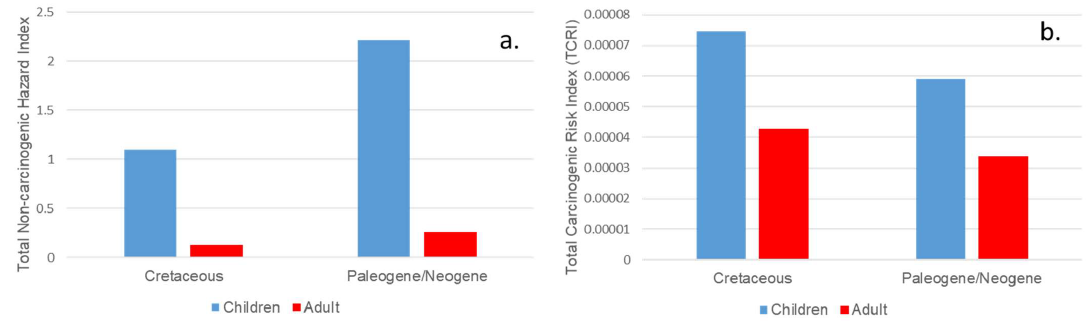
Figure 6. Plot of average total non-carcinogenic risk (a) and carcinogenic risk (b) for children and adults for trace elements in Cretaceous and Paleogene/Neogene geophagic kaolinitic clays within Eastern Dahomey and Niger Delta Basins, Nigeria.